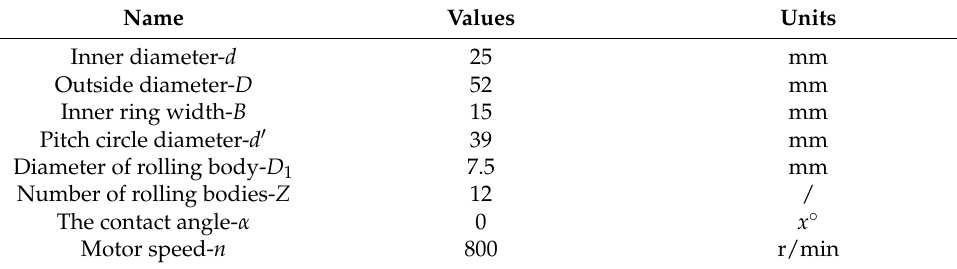
Table 1. Parameters of example toroidal drive